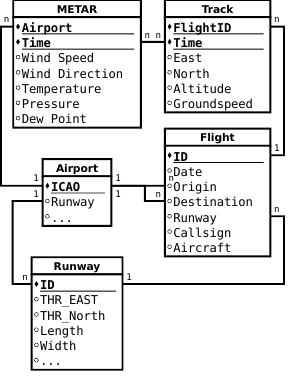
Figure 2. Schematic view on data sets and their